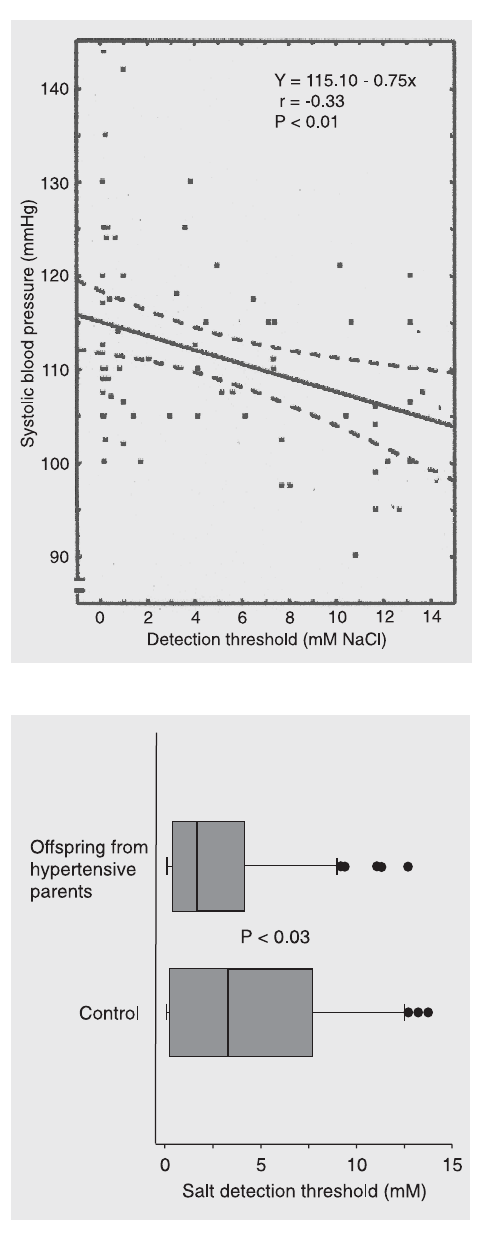
Figure 3. Negative correlation between sodium chloride detec- tion threshold and systolic blood pressure.